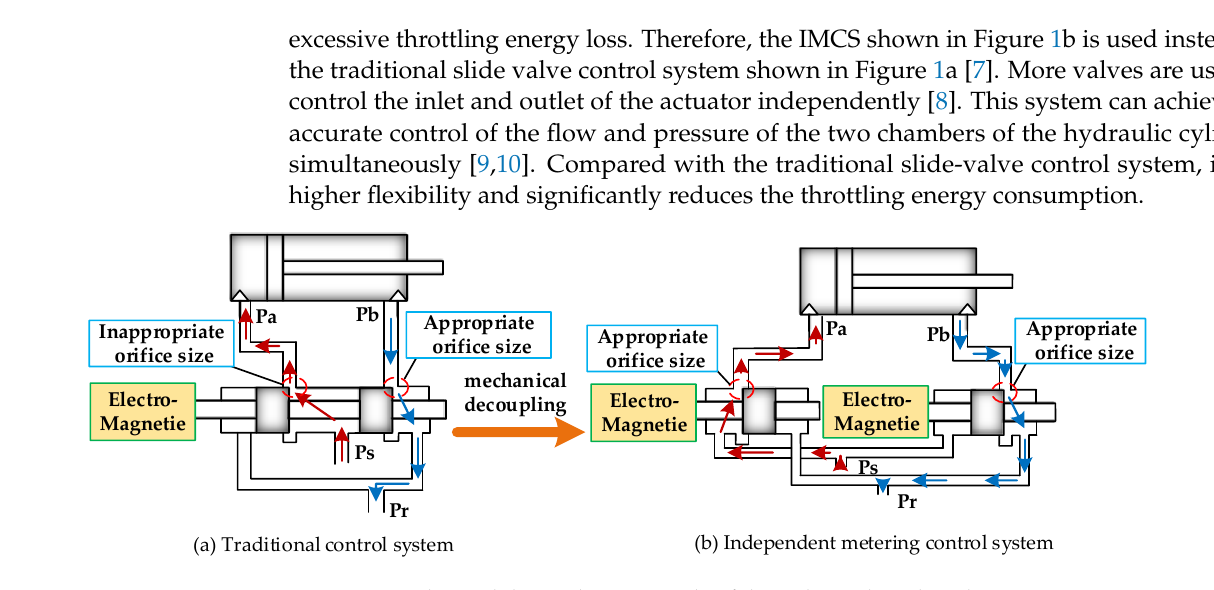
Figure 1. Mechanical decoupling principle of the independent throttling system.